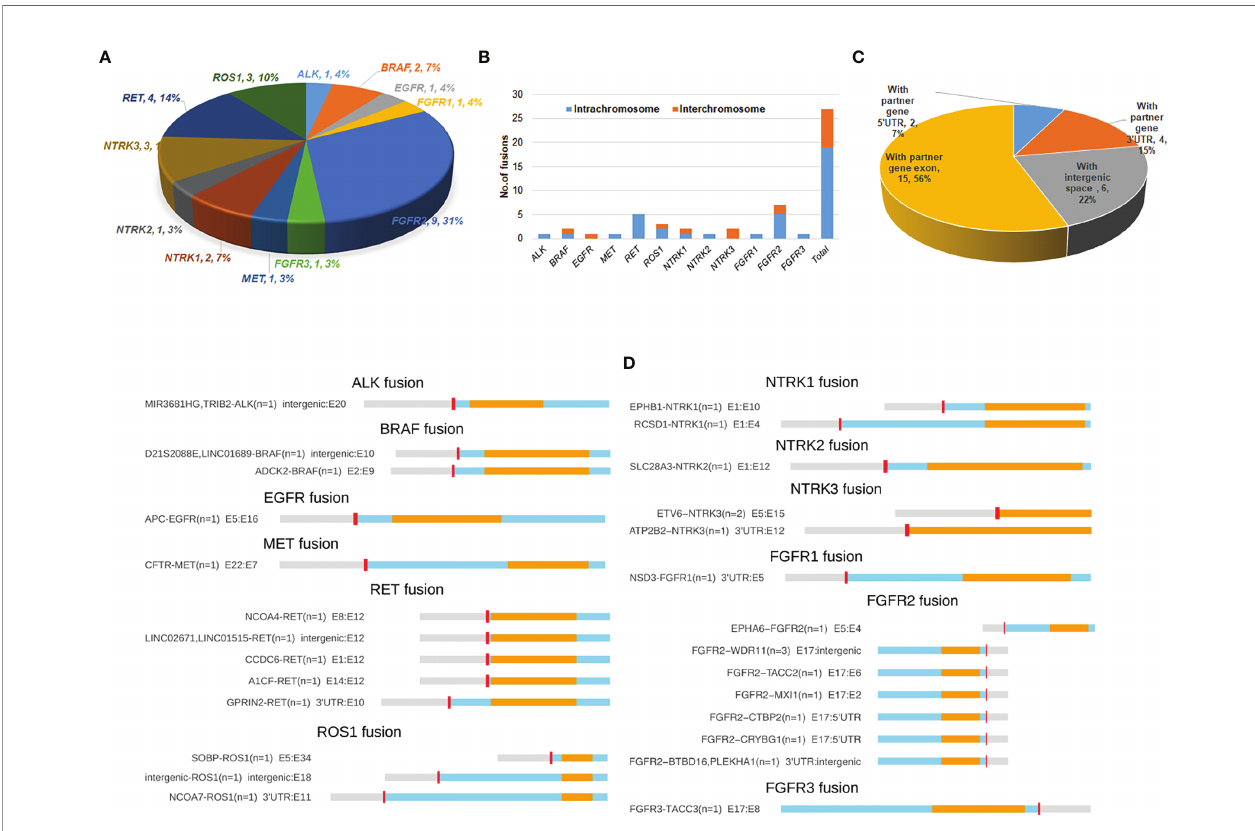
FIGURE 1 | Distribution and spectrum of RTK fusions. (A) The distribution of RTK fusion events in different genes (n=29). (B) Distrubution of fusion variants by RTK genes and different chromosomal rearrangements (n=27); (C) RTK fusion variants classi fi ed by different types of fusion partner (n=27); (D) Spectrum of RTK